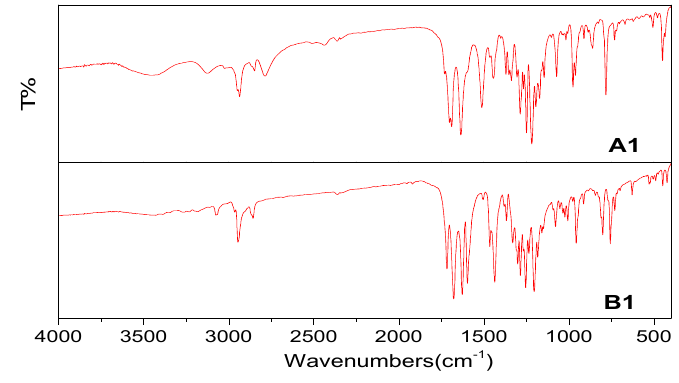
Figure 4. Infrared spectra of A1 and B1 .